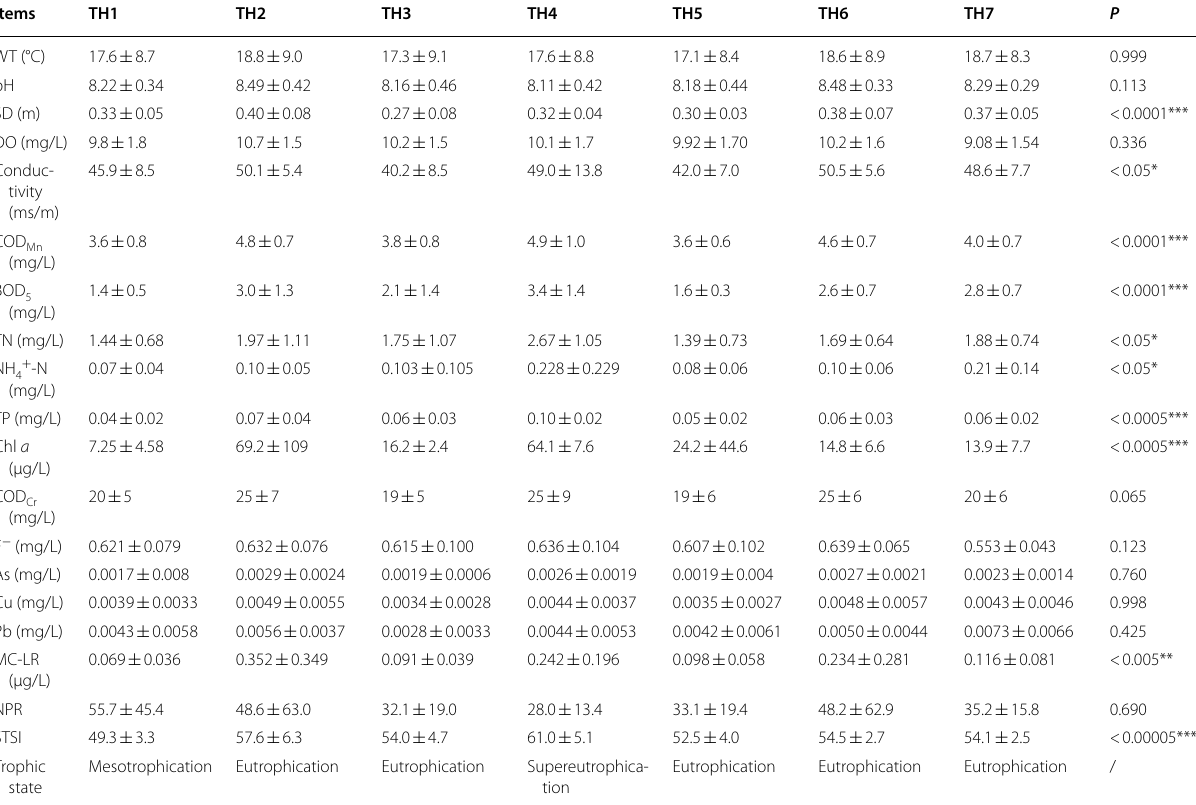
Table 1 Monthly values (mean SD) of water parameters at seven sampling sites from January to December of 2015 ± in Tai